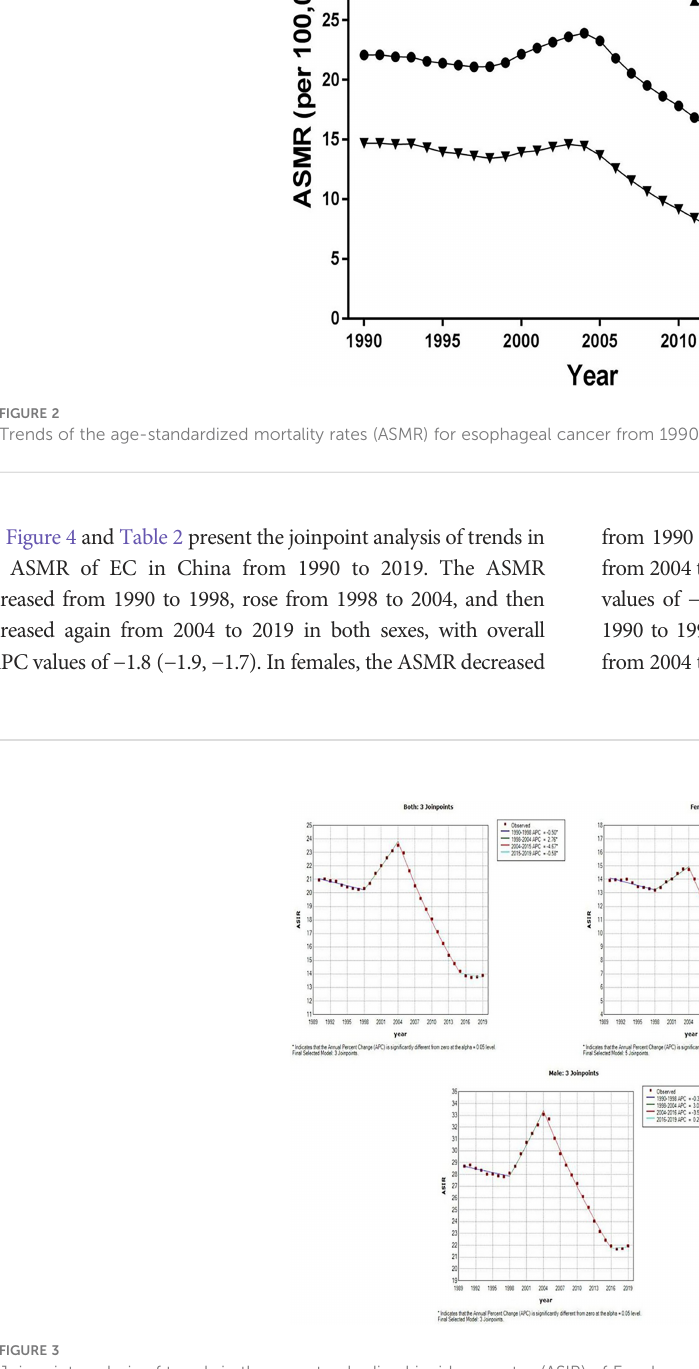
FIGURE 3 Joinpoint analysis of trends in the age-standardized incidence rates (ASIR) of Esophageal